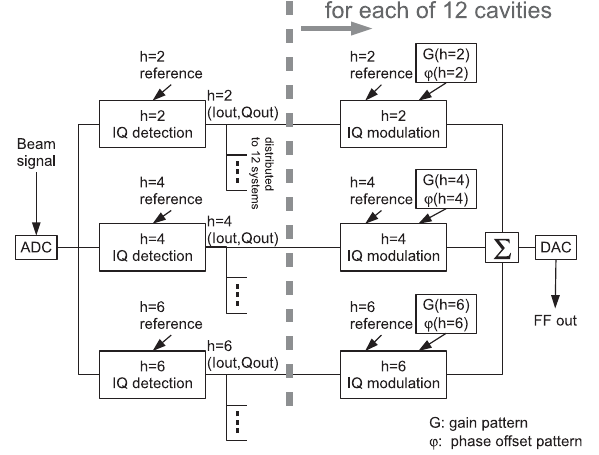
FIG. 4. Beam test setup. The commissioning of the feedfor- ward system is performed for each of the cavities. In the figure, #n is the cavity number. The signals are well